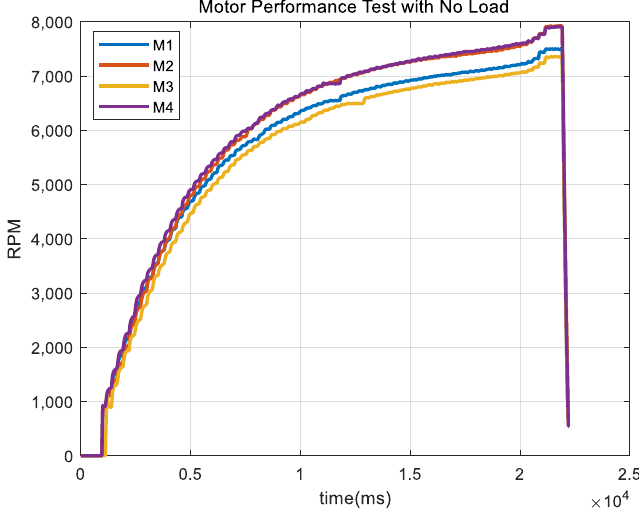
Figure 8. Experiment A result of motor speed response to changing control signals when four motors drive at the same time.